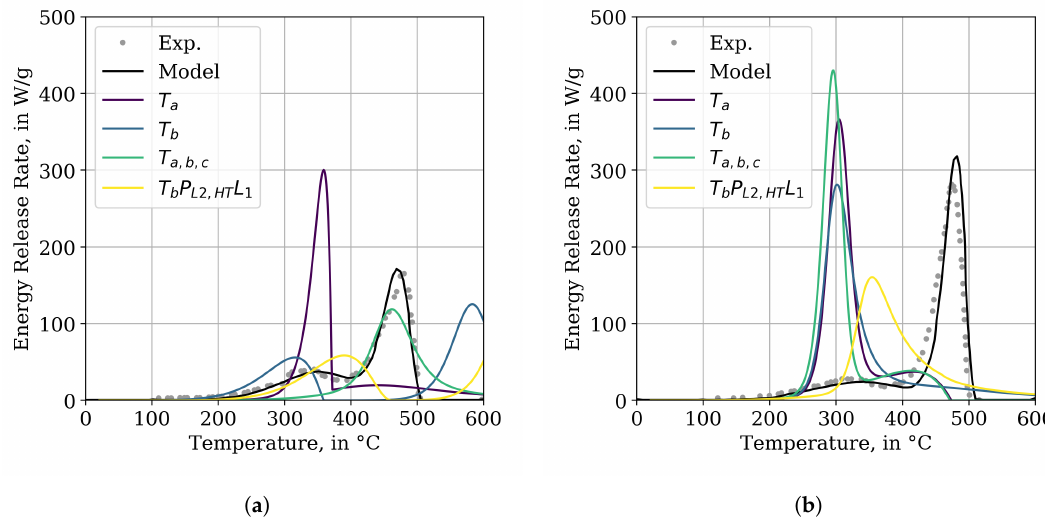
Figure 10. Comparison of energy release rates of MCC simulation ( TGA_ANALYSIS=.TRUE. ) of cable 219, across best parameter sets of different IMP runs, against experimental (Exp.) and model data [15]. ( a ) MCC simulation response of the jacket material. ( b ) MCC simulation response of the insulator material.